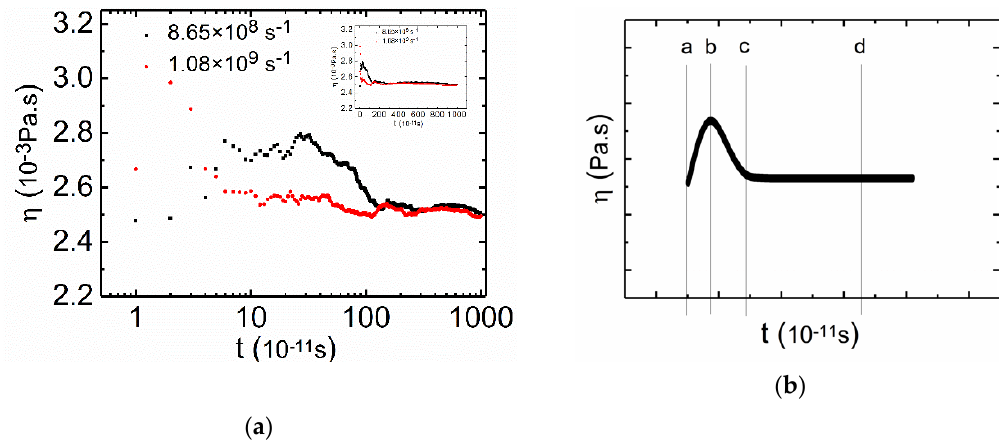
Figure 6. ( a ) Shear viscosity versus time at low shear rates for the CTAC based solutions shown in the logarithmic axis. The small figure is the same curve shown in linear axis. C CTAC = 0.2 mol·L − 1 , C PAM = 2.02 × 10 − 2 mol·L − 1 , counter ion salt is NaSal, R is 0.8, T = 300 K. Black square: shear rate is 8.65 × 10 8 s − 1 . Red circle: shear rate is 1.08 × 10 9 s − 1 . ( b ) Schematic diagram of the CTAC based solution under low shear rates.